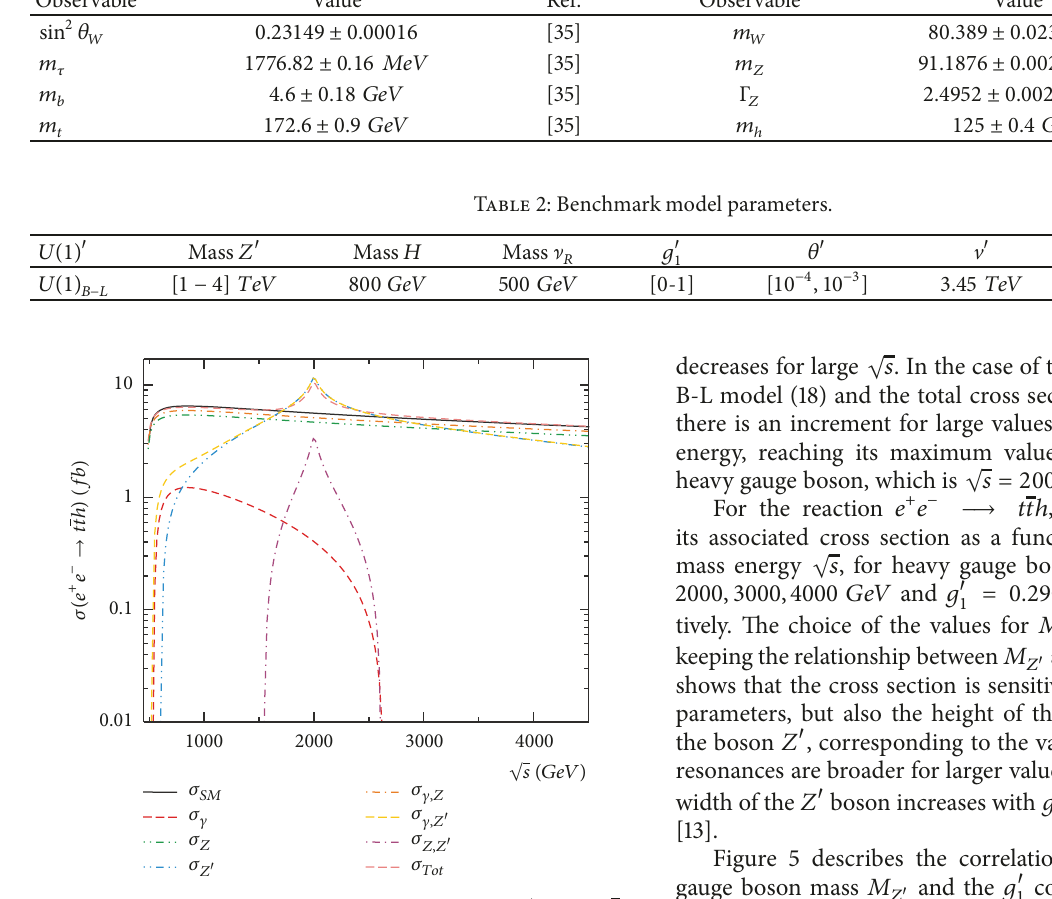
Figure 3: The cross section of the production process 𝑒 + 𝑒 − 󳨀→ 𝑡𝑡ℎ as a function of √𝑠 for 𝑀 푍 󸀠 = 2000 𝐺𝑒𝑉 and 𝑔 耠 1 = 0.290 .